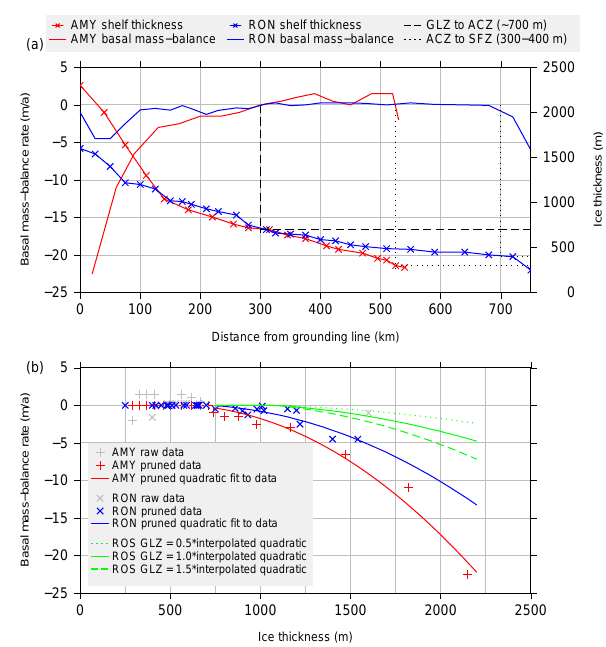
Fig. 4. Plots showing the (a) melt rate and thickness transects and (b) the GLZ quadratic law. The transects are as extracted from source publications for AMY (Wen et al., 2007) and for RON (Jenk- ins and Doake, 1991). The transitions, from which the threshold thicknesses are estimated, from GLZ to ACZ and ACZ to SFZ are shown in plot (a) . For the quadratic fits, once the basal mass bal- ance rate is > 0 m yr − 1 (i.e. onset of freeze-on and thus part of the ACZ), the remaining data points are all set to zero. The quadratic fit is made to this pruned